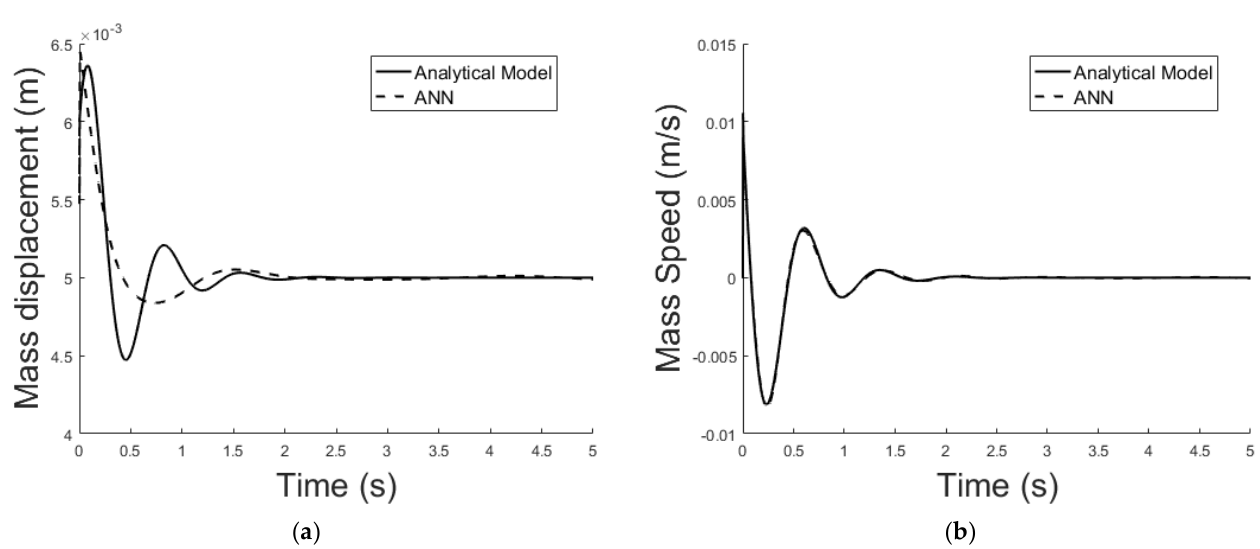
Figure 23. ( a ) Exact model mass displacement versus ANN model mass displacement, equilibrium at x = 0.005 m; ( b ) exact model mass speed versus ANN model mass speed, equilibrium at x = 0.005 m.